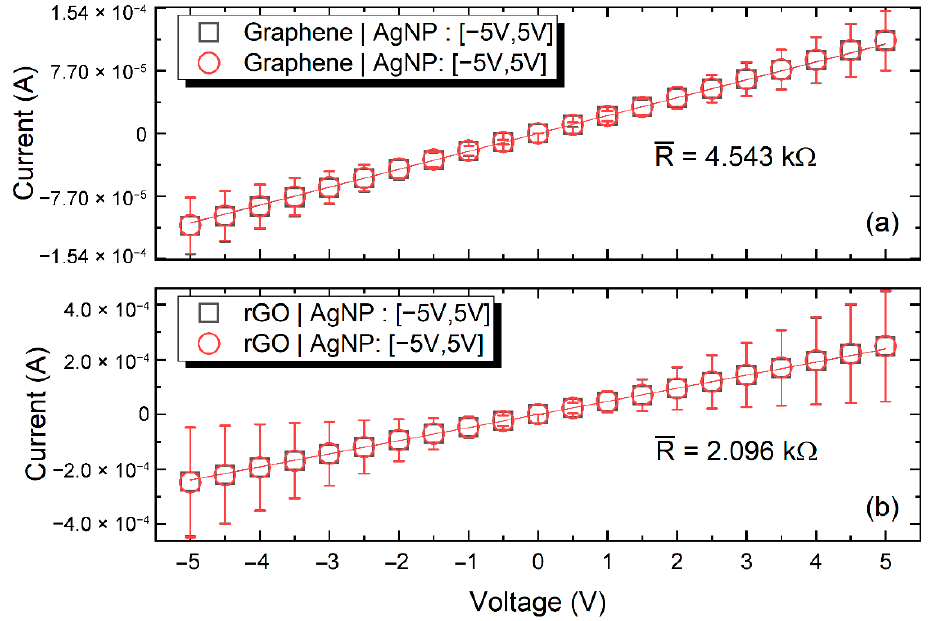
Figure 9. Graphene ‐ AgNP junction IV curve ( a ); f ‐ rGO ‐ AgNP junction IV curve ( b ). Figure 9. Graphene-AgNP junction IV curve ( a ); f -rGO-AgNP junction IV curve ( b